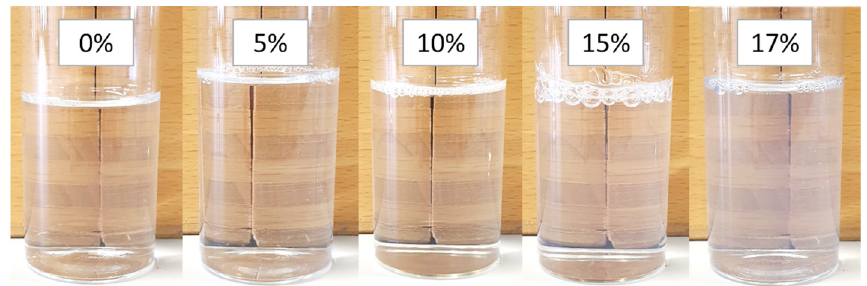
Figure 8. Comparison of the four outer water phases used plus another two percent polyvinyl alcohol solution with 17% ammonium chloride. No turbidity can be seen between 0% and 10%. At 15%, a very weak turbidity can be seen, which is more pronounced at 17%.